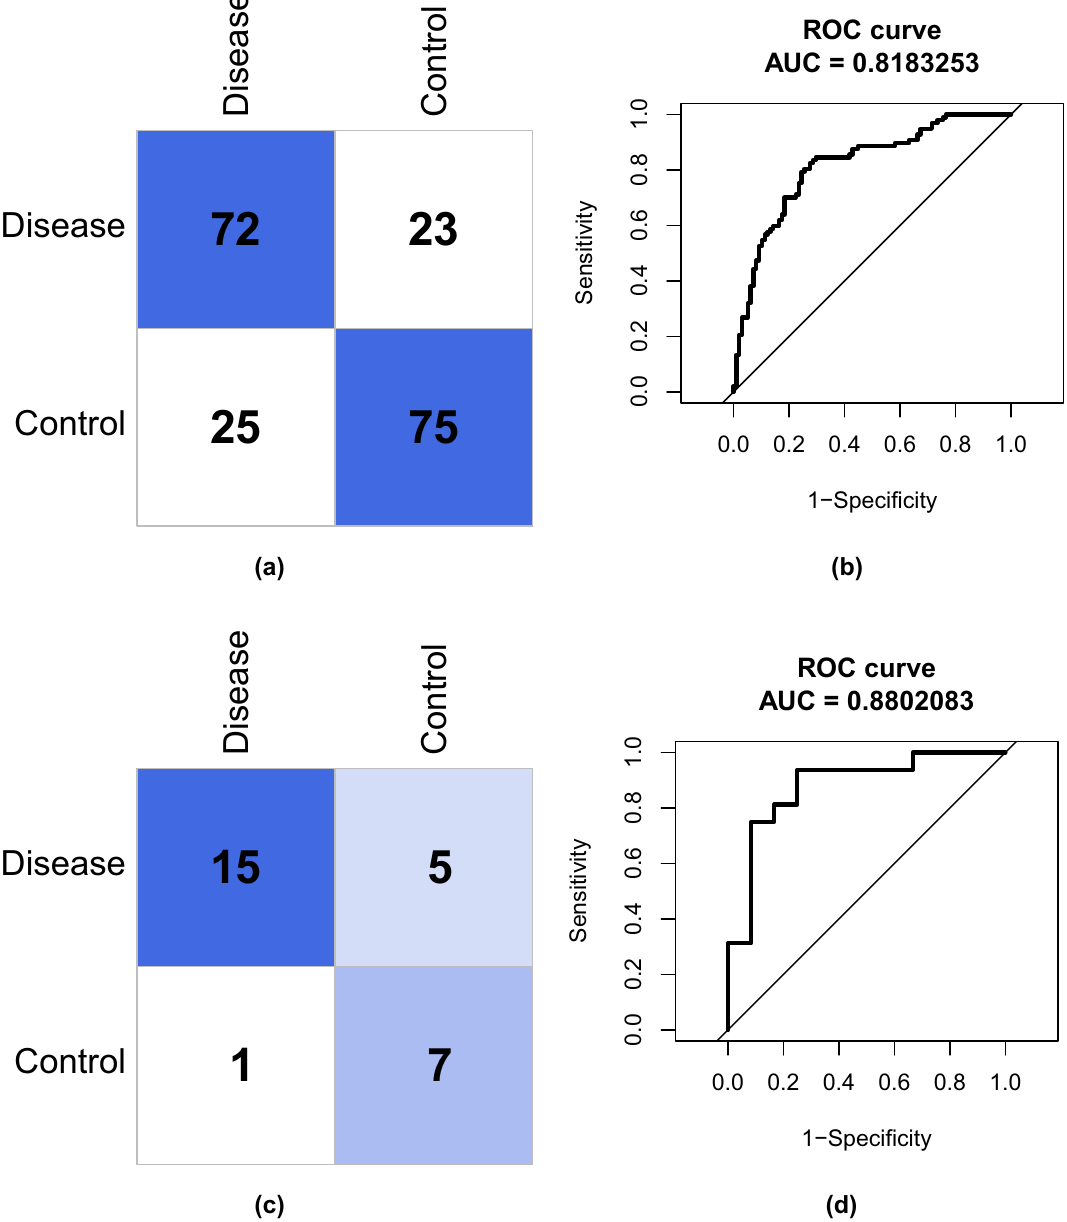
Figure 18. ( a ) Confusion matrix for training set. ( b ) ROC curve for training set. ( c ) Confusion matrix for validation set. ( d ) ROC curve for validation